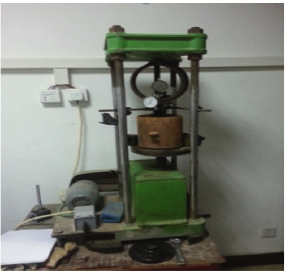
Figure 3: Splitting strength test.